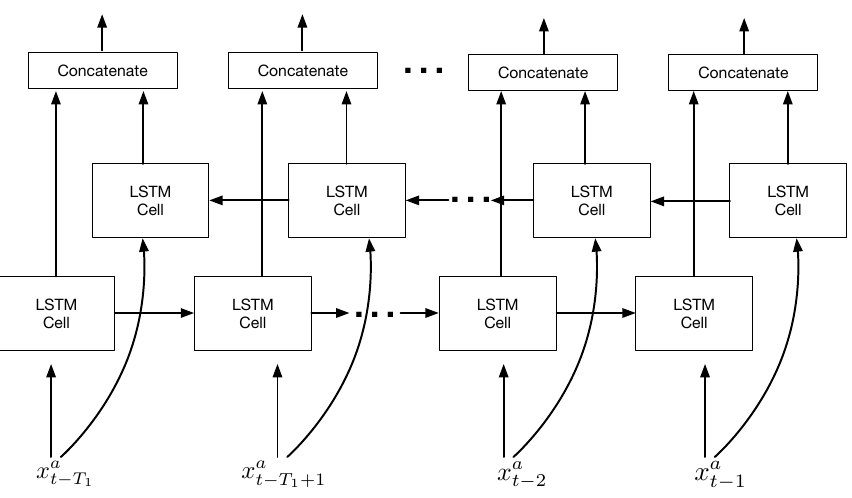
Figure 2. Architecture of a bidirectional LSTM